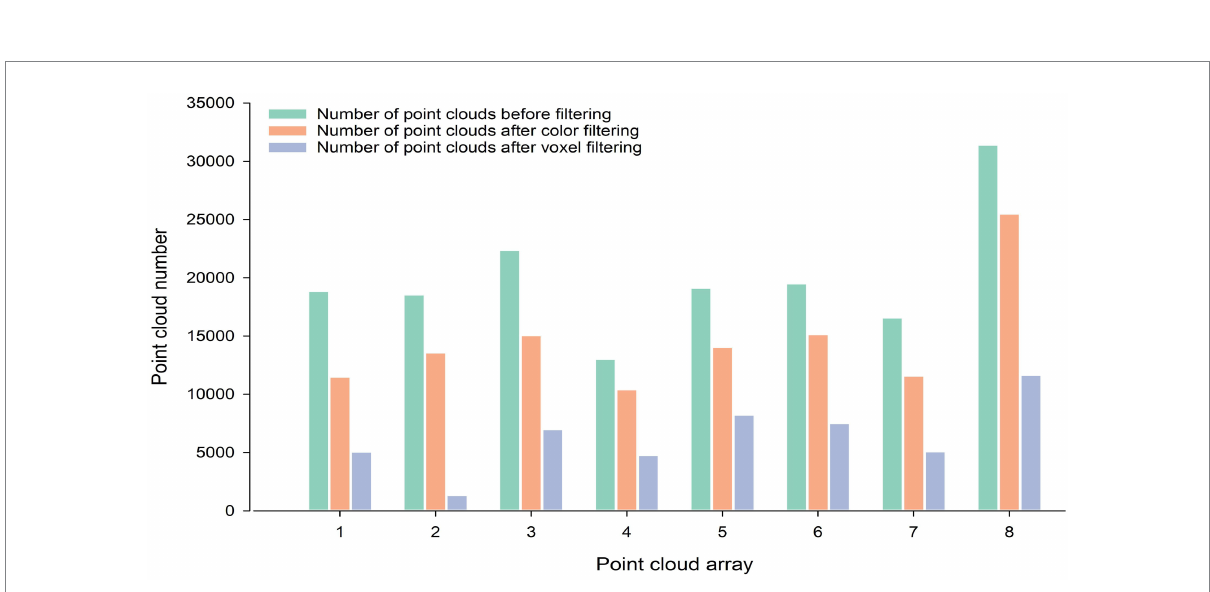
FIGURE 6 Number of point clouds before and after filtering. The three colors indicate the number of point clouds before filtering, the number of point clouds after color filtering, and the number of point clouds after voxel filtering,